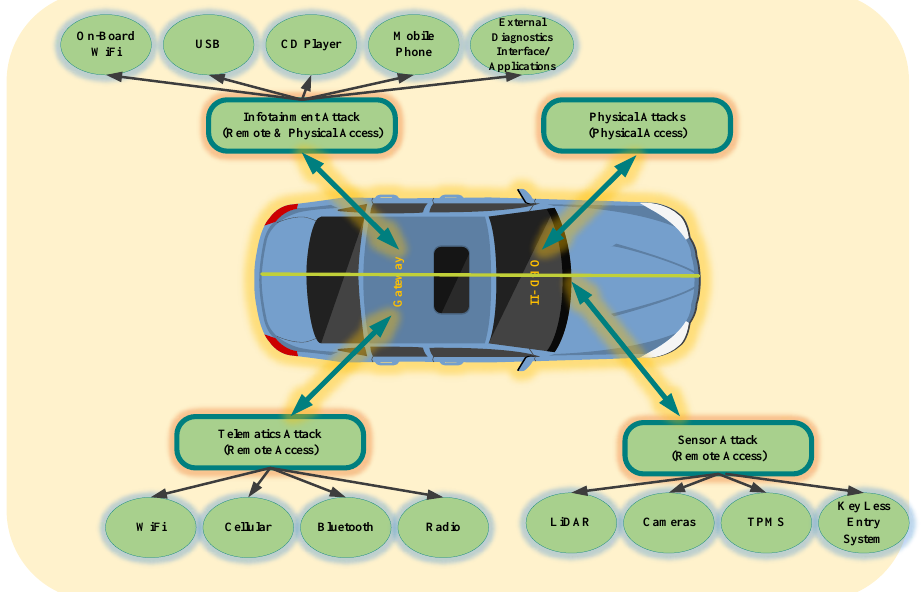
Figure 7. Classification of in-vehicle network attacks.